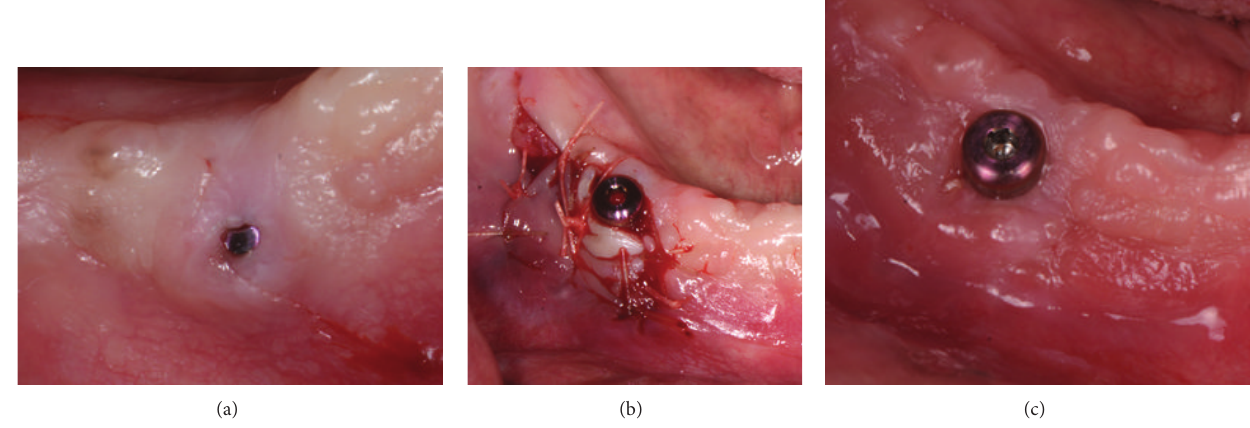
Figure 3: (a) Presurgical appearance of an implant supporting overdenture, 1mm keratinized tissue. (b) Pedicle graft elevated and suture buccally. (c) Final result with 3 mm gain of keratinized tissue.